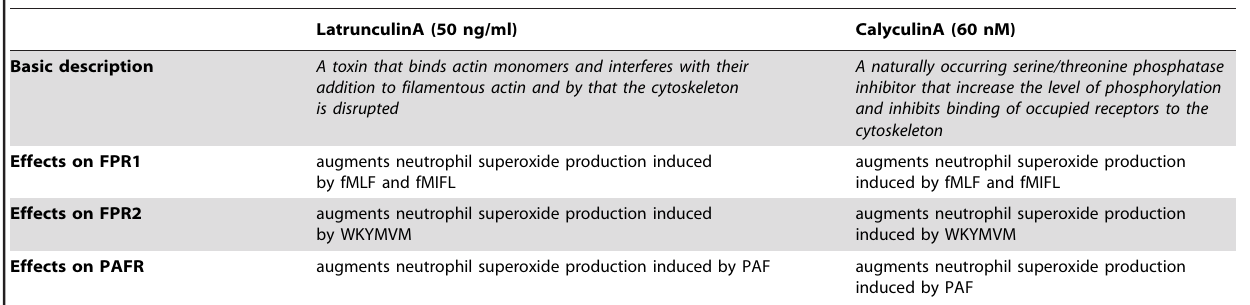
Table 2. Characteristics of cytoskeleton interfering drugs used.